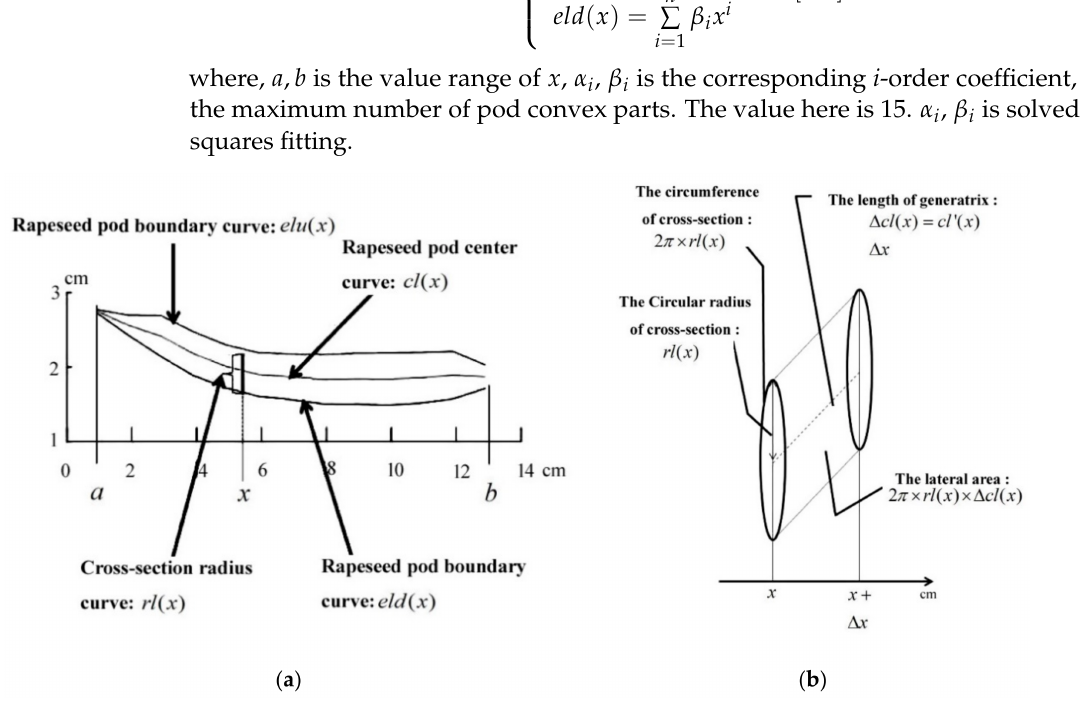
Figure 6. The indices related to rapeseed pods and their surface area calculation. ( a ) Rapeseed pod curve of calculations of the boundary, center, and cross-section radius curves; ( b ) Calculation of the side area of the cylinder of rape pod